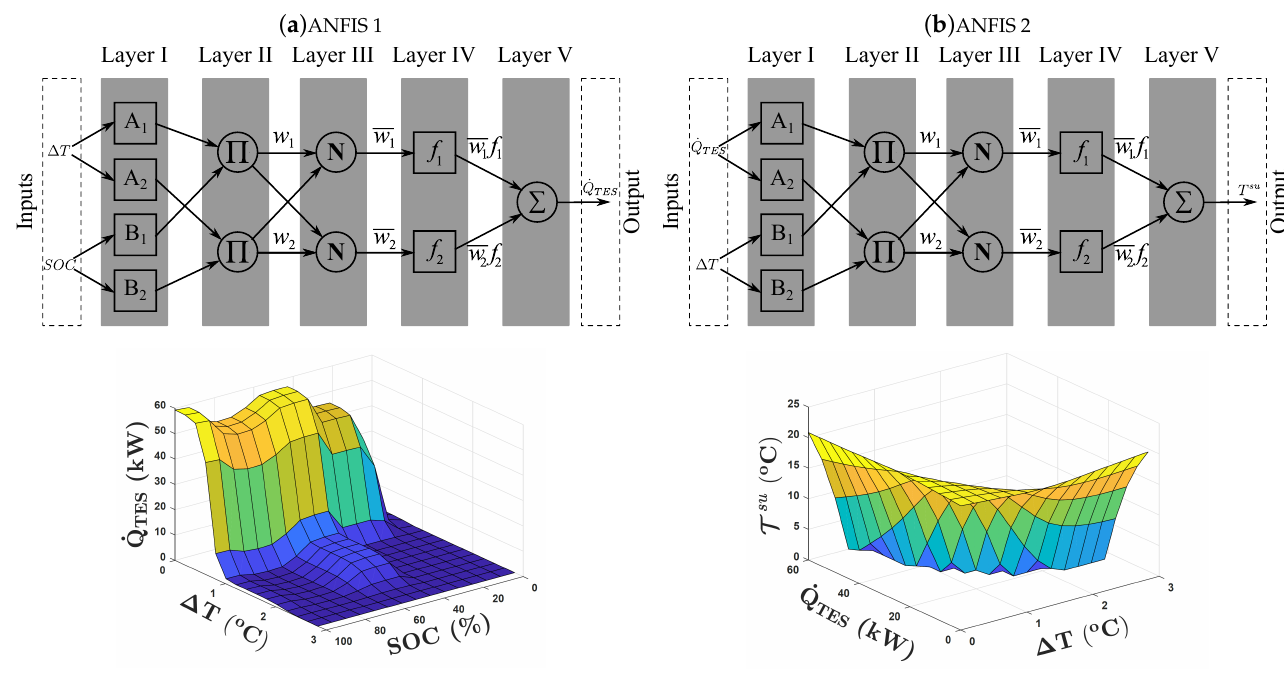
Figure 15. Structure of the EMPC-trained ANFIS controller for the combined MicroCSP and HVAC